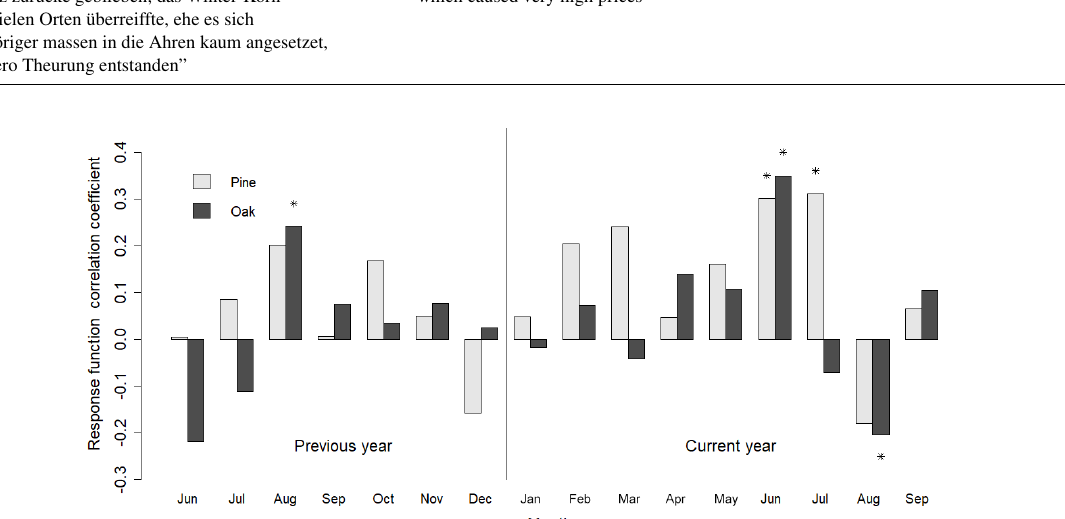
Figure 2. Climate growth relationships between tree rings in pine (grey bars) and oak (black bars) and monthly totals of precipitation. Key: asterisks indicate statistically significant correlation coefficients at the level of 0.05. Climate data were taken from Toru´n Meteorological